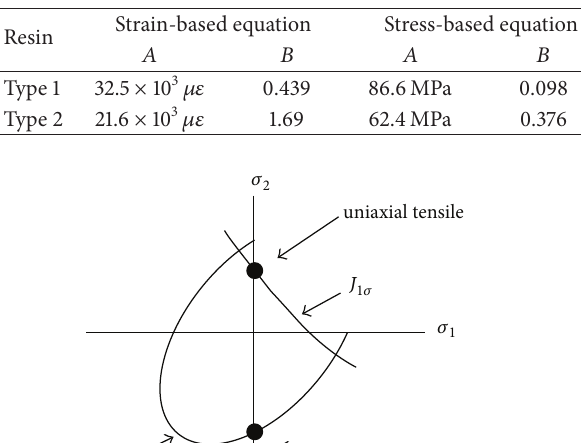
Table 2: Parameter 𝐴 and 𝐵 values.